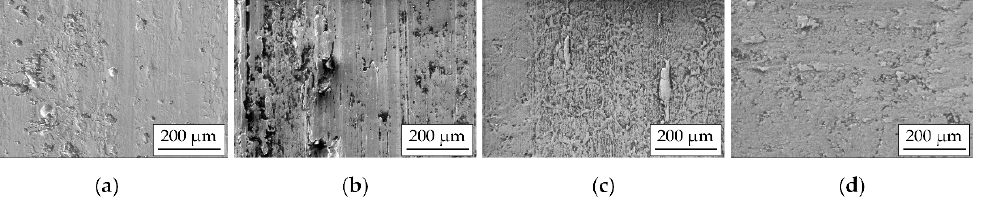
Figure 14. SEM images of wear tracks after friction with 316L stainless steel; untreated titanium ( a ), nitrided samples at 750 °C ( b ) and 900 °C ( c ), and borided sample ( d ).